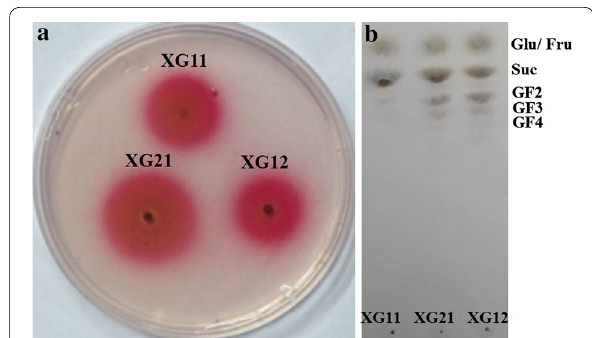
Fig. 1 Screening of fungal strains based on their ability to produce FFase and synthesize FOS. a Detection of glucose released from sucrose around the fungal colonies grown in the CD plate by a glucose oxidase–peroxidase coupled reaction. XG11, XG21 and XG12 are the fungal strains obtained from the sugarcane molasses habitat. b TLC analysis of the resulting saccharides from the transfructosyla- tion reaction by the fungal strains XG11, XG21 and XG12. Glu glucose; Fru fructose; Suc sucose; GF 2 kestose; GF 3 nystose; GF4 fructofuranosyl